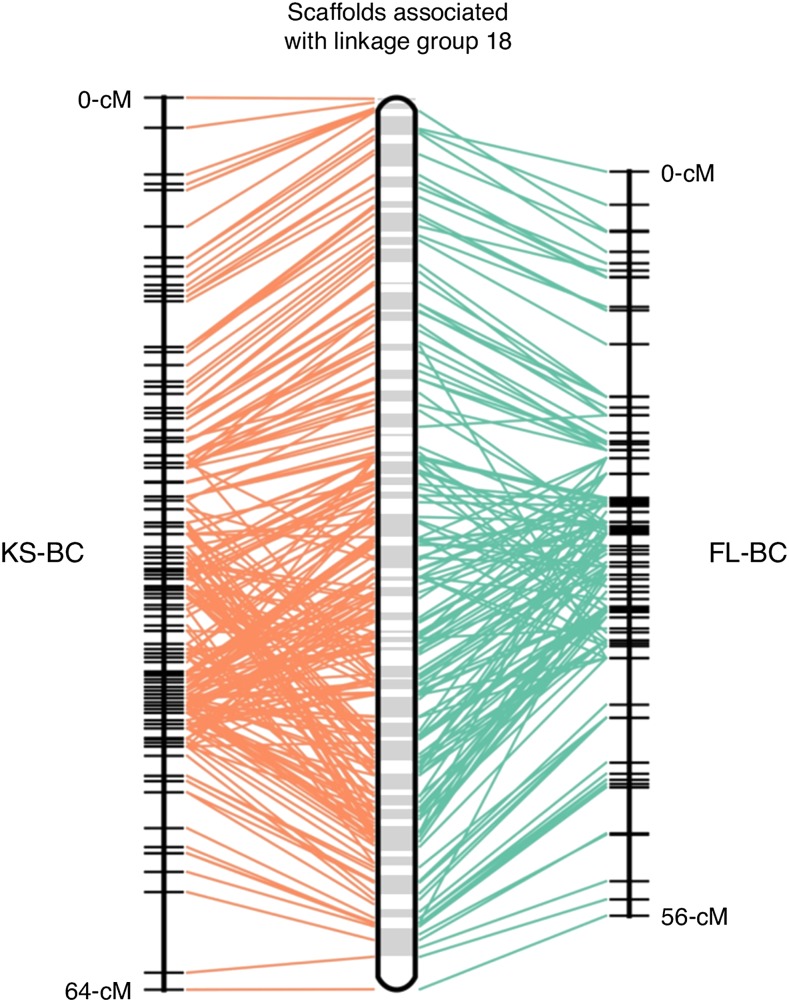
Marker order inconsistency between backcross populations. ALLMAPS was used to map genetic markers to our genome scaffolds separately for each backcross. Blocks in the central chromosome represent scaffolds, and lines connect these physical positions to the genetic positions in each map for markers on linkage group 18. The presence of crossed lines indicates map order inconsistency, which is particularly evident in the central portion of the chromosome.